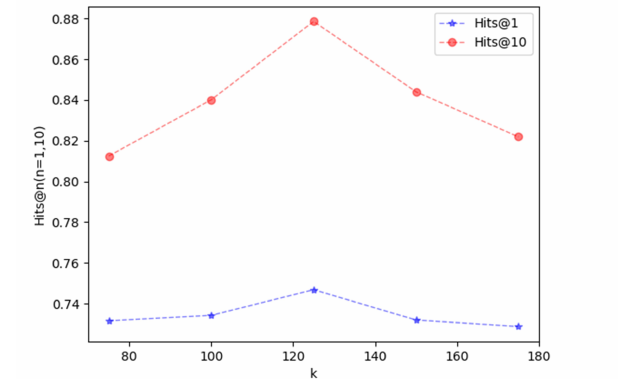
Figure 10. Effect of different k values on Hits@n (n = 1,